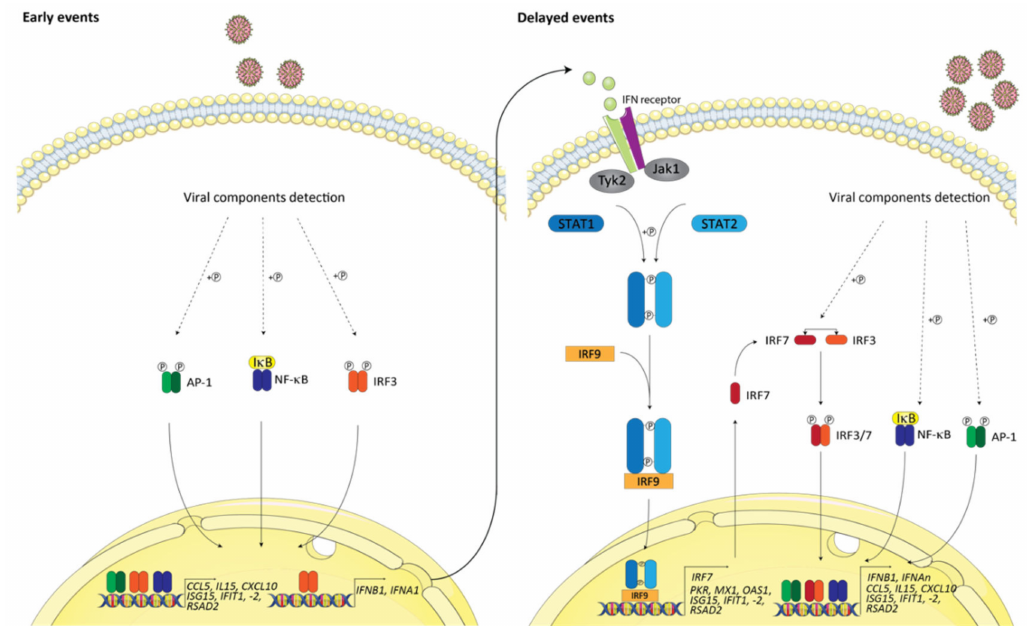
Figure 2. Early and delayed events in interferon signaling. The recognition of viruses by cells triggers the rapid activation of multiple latent transcription factors, namely nuclear factor-kappa B (NF- κ B), activator protein 1 (AP-1) (ATF-2 / c-Jun), and interferon regulatory factors (IRFs) via the I κ B kinase (IKK) complex, mitogen-activated protein kinases (MAPKs), and IKK-related kinases, respectively (not shown). These transcription factors, in turn, directly activate a set of immunomodulatory genes including interferon (IFN)-stimulated genes (ISGs) and cytokines (RANTES, IP-10, and type I IFN). Once secreted, type I IFNs (IFN- α and IFN- β ) act in a paracrine and autocrine fashion to amplify the initial production of type I IFN and to induce other ISGs. In fact, upon binding to interferon- α / β receptor (IFNAR), type I IFN leads the activation of Tyk2 and Jak1, which then phosphorylate signal transducer and activator of transcription 1 (STAT1) and STAT2, leading to their dimerization and to the recruitment of IRF9 to form the ISGF3 complex. The binding of this complex to interferon-stimulated response elements (ISRE) found in the promoter of a multitude of ISGs, including IRF-7, thus results in the amplification of antiviral response. IRF3 / IRF7 heterodimers, in conjunction with AP-1 and NF- κ B, allow for the production of type 1 interferons and ISGs, resulting in growth inhibition, apoptosis, and impaired viral gene expression and replication. The AP-1 complex depicted here is composed of the ATF-2 / c-Jun heterodimers. Following the phosphorylation of ATF2 by the MAPK p38 / JNK (jun kinase) in the cytoplasm and the translocation of these activated protein kinases into the nucleus where they also target c-Jun, the formation of an active AP-1 complex, in fact, occurs in the nucleus following virus infection (for the simplicity of figure, the activating kinases are not shown). The model was created using Servier Medical Art templates (www.servier.com) licensed under a CC BY 3.0 license (https: // creativecommons.org / licenses / by / 3.0 /